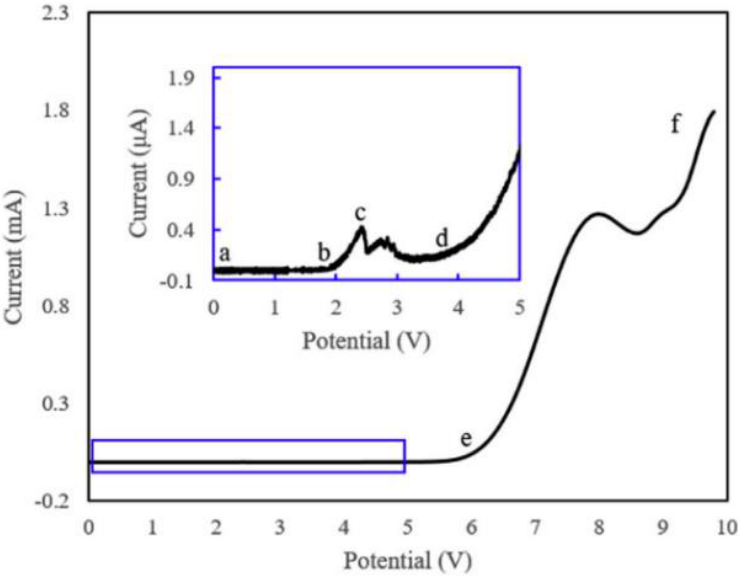
Figure 24. Linear scanning voltammetry (LSV) result for 4H-SiC [57]. The mode of the anodic oxidation process of the 4H-SiC surface is shown in Figure 25. In the initial oxidation stage as shown in Figure 25b, the edges of the scratches and SSD were preferentially oxidized, while the remaining part of the surface was passivated. If the oxidation potential was insufficient to break down the passive film, the further oxidation of the surface was hindered by the passive film, and only scratches and SSD were oxidized. On the contrary, if the potential was sufficient, the passive film would be broken down at the atomic pits, and then the current was concentrated at the breakdown due to the low resistance, which resulted in the oxide protrusions (etching pits) as shown in Figure 25c. Anodic oxidation was the oxidation of SiC by the hydroxyl group in the electrolyte. In the initial stage, the diffusion of hydroxyl groups was not significantly hindered by the oxide protrusions with a relatively small thickness, so the longitudinal growth of pits occurred. In the late-growth stage, with the increasing thickness of the oxide protrusions, the diffusion of hydroxyl groups in the oxide layer became difficult, particularly at the center of the pits, and this resulted in the lateral growth of the pits. Therefore, for SiC’s ECMP process, the surface damage layer should be completely removed by oxidation at a high oxidation